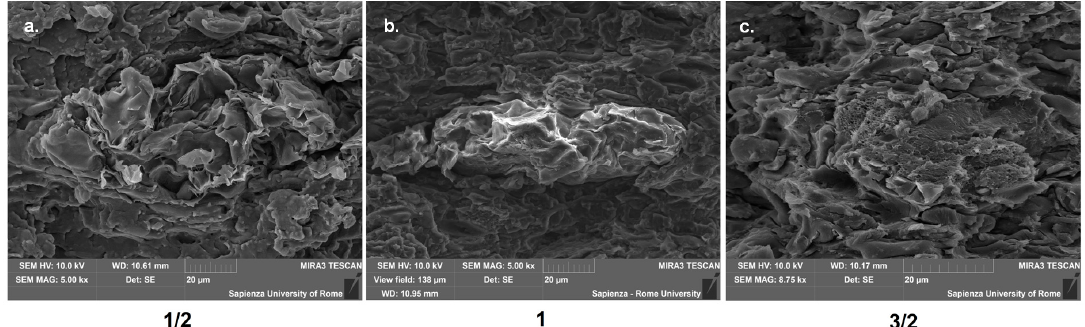
/ 2 ( a ), 1 ( b ) 3 / 2 ( c ). Polymers 2020 , 12 , x FOR PEER REVIEW